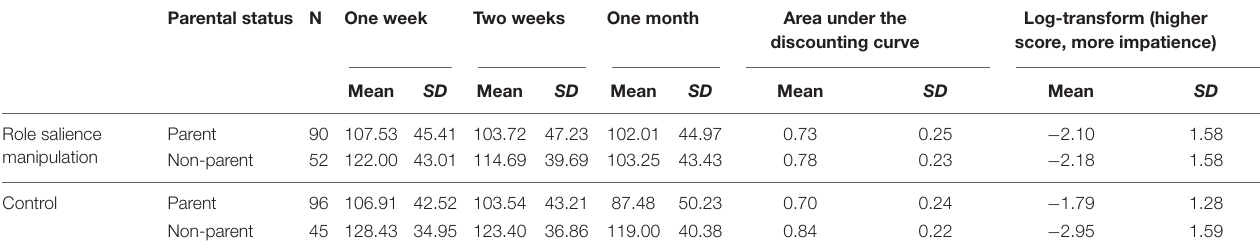
TABLE 1 | The average indifferent smaller-sooner values of $150 at diverse time slots across conditions. Parental status N One week Two weeks One month Area under the